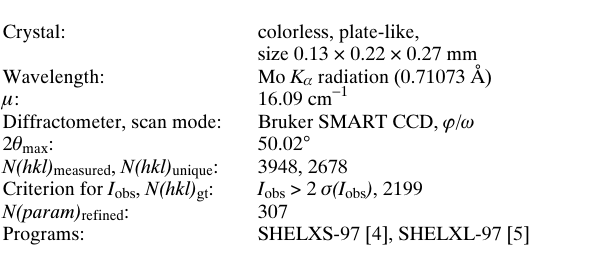
Table 1. Data collection and handling.